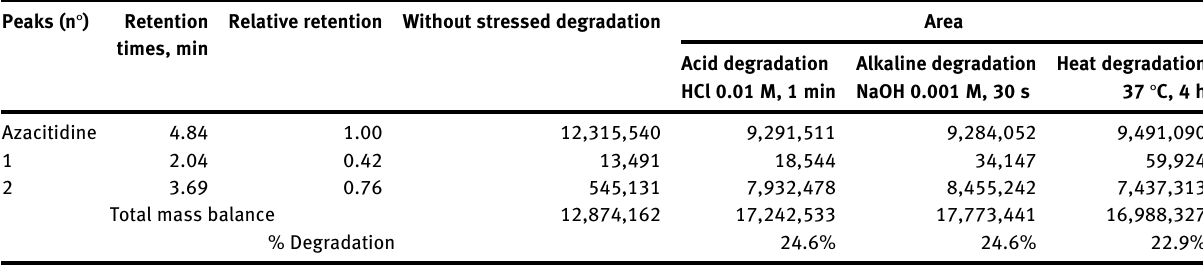
Table  : Mass balance of azacitidine suspension after various stressed degradation (expressed as peak areas). Peaks (n ° )